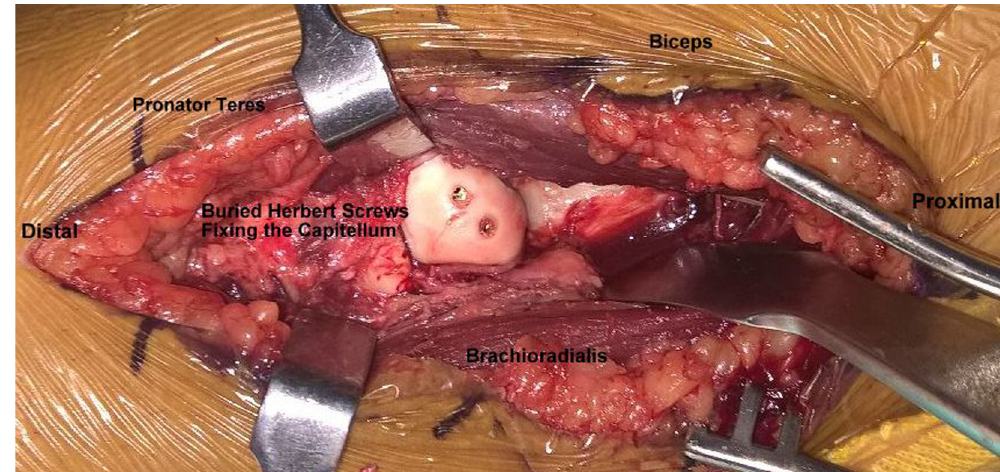
Figure 6. Intra operative image of fi xation using buried Herbert screws.